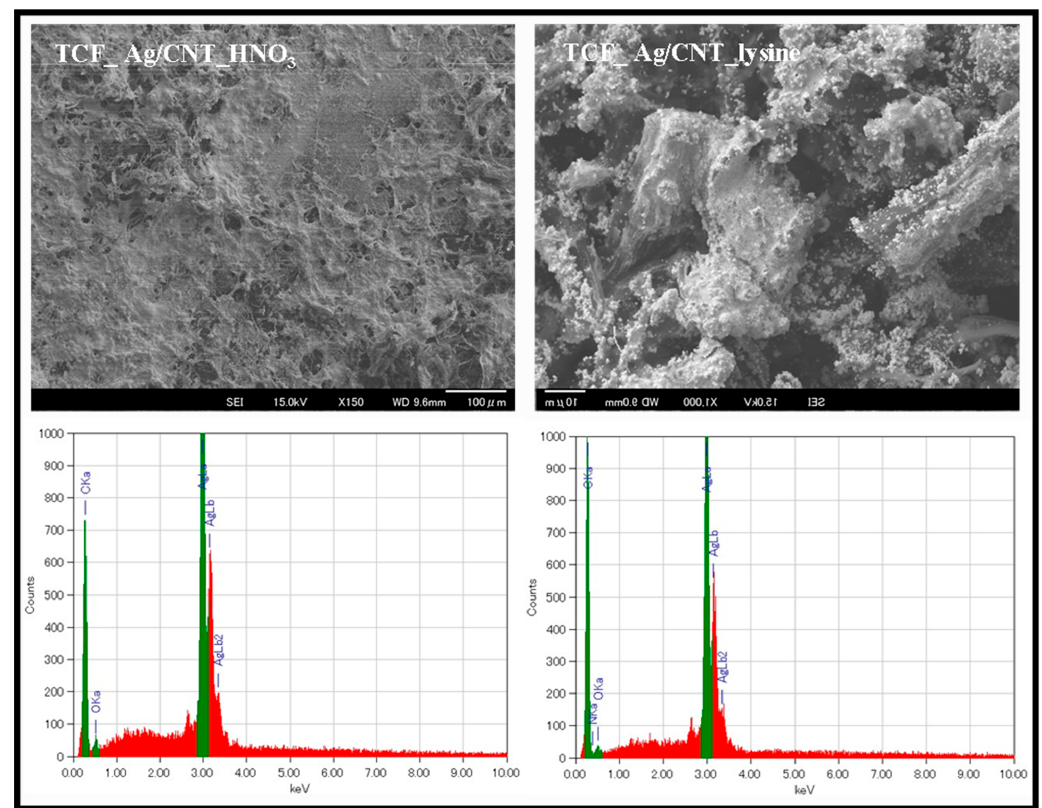
Figure 7. FE ‐ SEM images and EDS analysis of AgNP/MWCNT nanocomposites. Figure 7. FE-SEM images and EDS analysis of AgNP/MWCNT Table 1. Ratio of Ag element (mass %) in TCF_Ag/CNT nanocomposites.